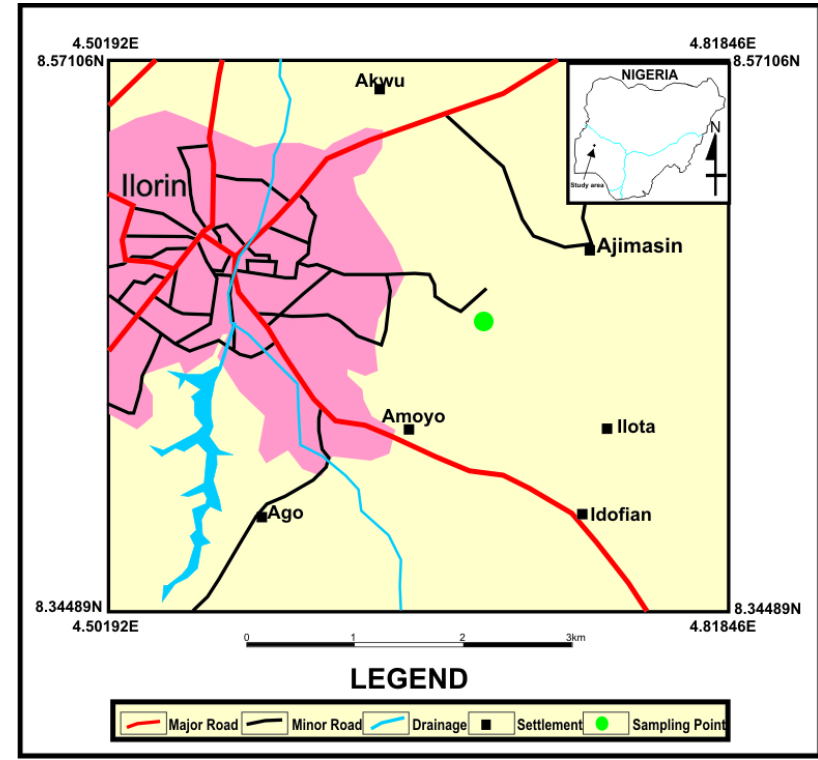
Figure 9. Map showing sample collection site.